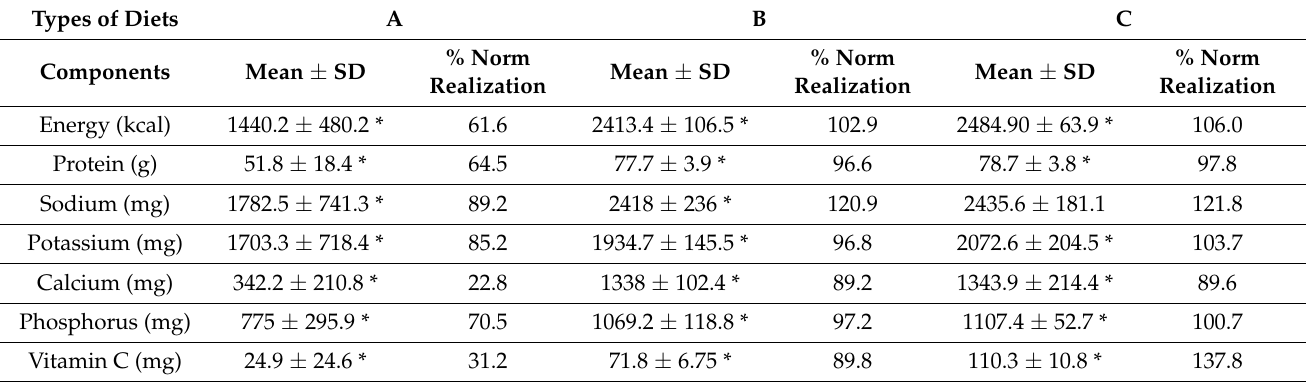
Table 3. Average energy content and selected components of